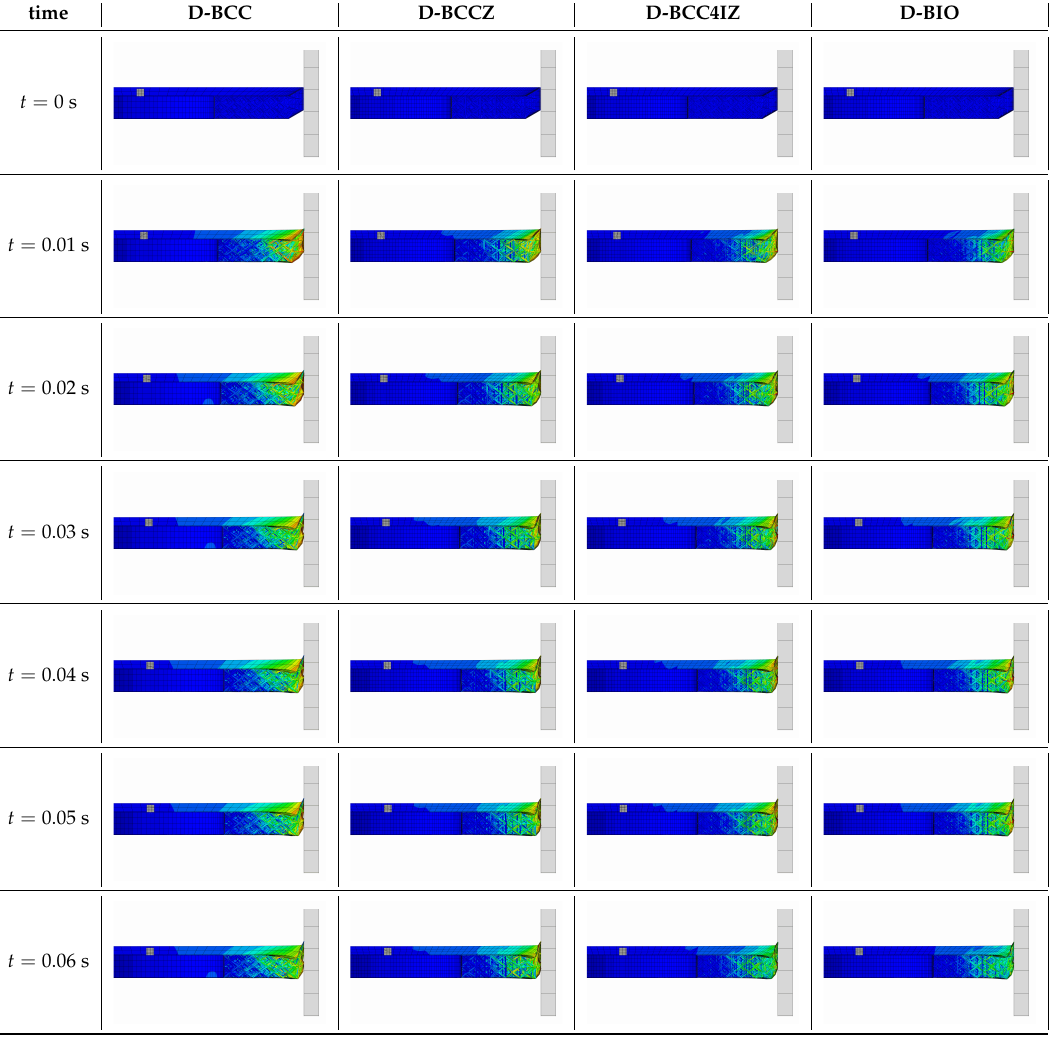
Figure 18. Landing cushioning process magnitude displacement results of the four designs under a horizontal cushioning condition.